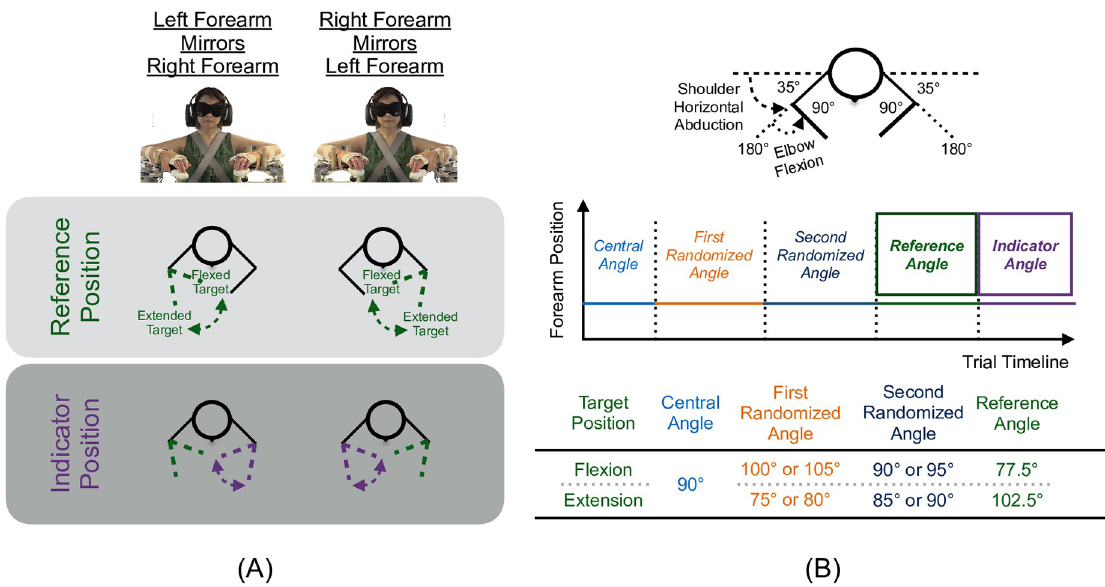
Fig 1. Experimental procedures. (A) The participant’s reference forearm, shown in green, rotated to the target position, and their indicator forearm, shown in purple, rotated to mirror their reference forearm’s position. This task was performed when the participant’s forearms were moved passively and actively to an extension and flexion target. (B) Top: Top-down visual depiction of how the shoulder elbow angles were defined, with the dashed horizontal line and error indicating 35˚ in shoulder horizontal abduction and the solid and dotted lines identifying 90˚ and 180˚, respectively, in elbow flexion. Middle: Summary of the positions to which the participant’s forearms rotated throughout a trial. Bottom: Angles to which the participant’s reference forearm rotated during an extension and flexion trial. The individual in this manuscript has given written informed consent, as outlined in the PLOS consent form, to publish these case details. This figure was adapted from Gurari et al., 2018 ©